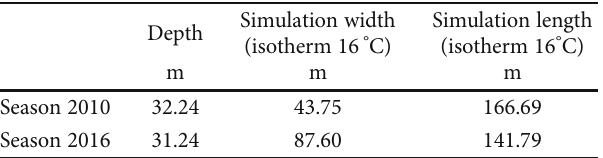
Figure 7: Politecnico di Torino open-loop geothermal system thermal a ff ected zone after seasons 2010 and 2016. We highlighted the reinjection well (P4) in the real location and its projection downstream of the abstraction well, along groundwater fl ow direction. Table 4: Simulated maximum thermal plume width ( W pl ) and length ( L pl ) for each monitored season, 2010 (128 simulation days) and 2016 (90 simulation